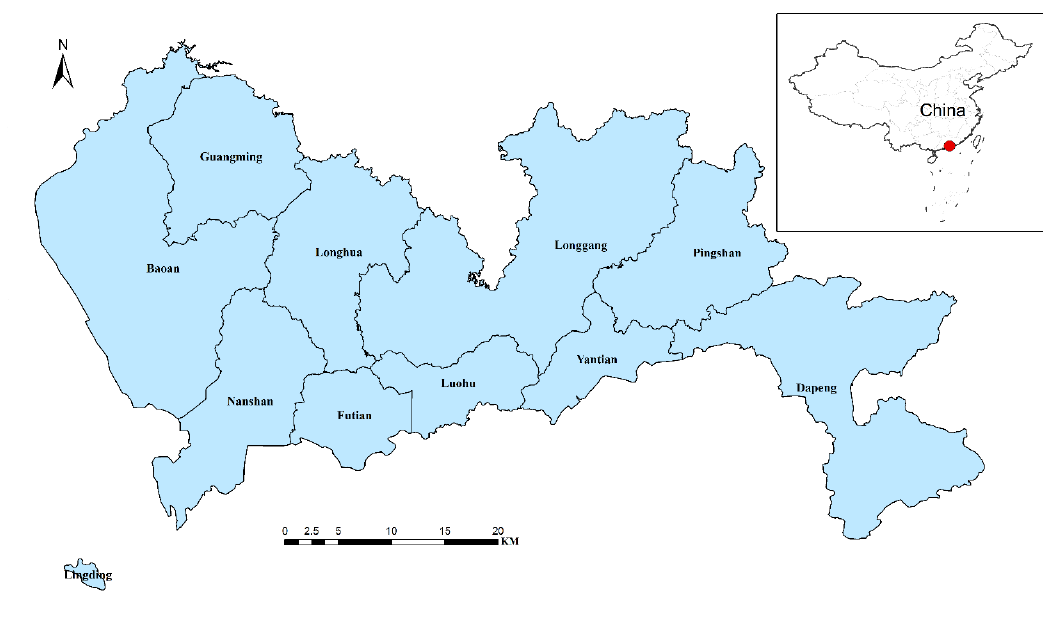
Figure 1. A map of Shenzhen and its location in